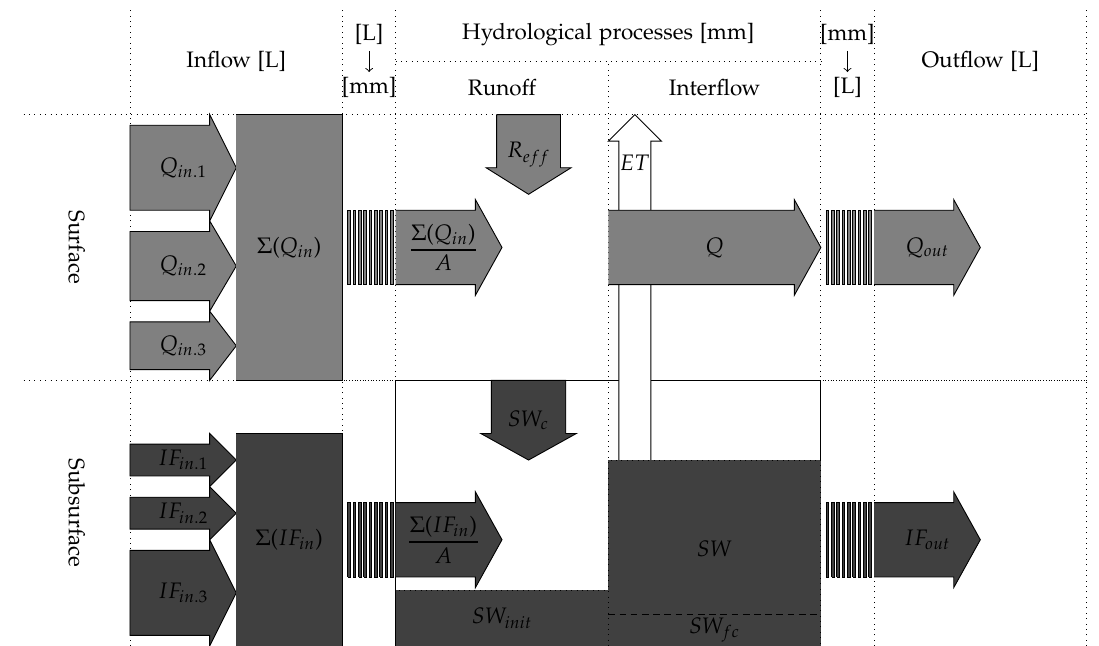
Figure 1. Schematic hydrological processes within an element. The hydrological phase estimates the amount of surface runoff ( Q ; mm) and subsurface interflow ( IF out ; L) generated from an element. Assuming that the surface area of an element is A (m 2 ), surface water inputs of an element is the effective rainfall ( R ef f ; mm) and surface water contribution from upslope elements ( Σ ( Q in ) / A ; mm). Surface runoff occurs when surface water inputs exceed surface water infiltration capacity, ( SW c ; mm) which depends on available soil pore space left for surface water infiltration and the proportion of the impervious surface area ( IMP ). The subsurface interflow occurs when the soil water budget ( SW ; mm) exceeds the soil water at field capacity ( SW fc ; mm). In this condition, a part of the excess soil water outflows from an element as an interflow, and the surface runoff and subsurface interflow generated in an element are discharged to downslope